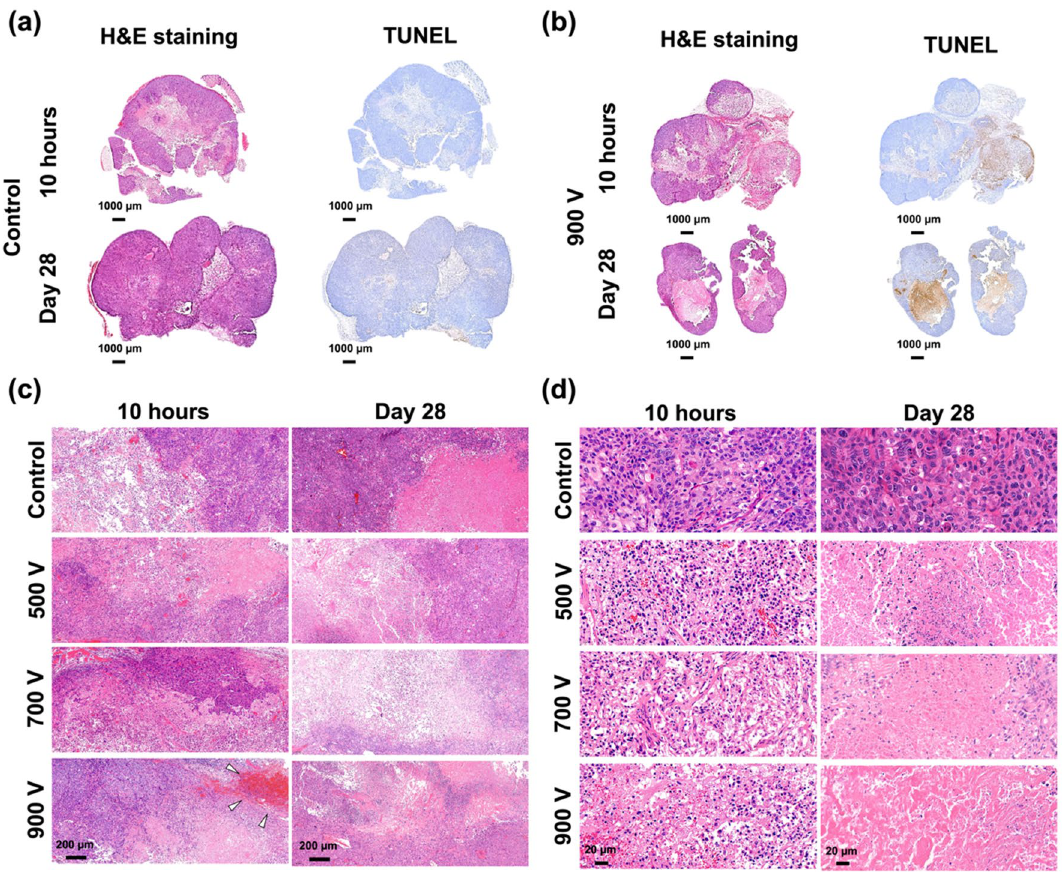
Figure 3. Representative microscopic images of tumor tissue at different applied voltages. ( a – b ) Hematoxylin and eosin (H&E) staining and terminal deoxynucleotidyl transferase-mediated dUTP nick and labeling (TUNEL) assay revealed ( a ) natural necrosis at 10 h and 28 days in the control group and ( b ) destructive findings after irreversible electroporation (IRE) ablation in the 900 V group. ( c ) Histological images showing extensive tumor apoptosis and necrosis in all groups and bleeding (arrowheads) in the 900 V group. ( d ) Magnified histological images showing remnant cells in apoptosis and condensed cellular nuclei at post- procedural 10 h and shrunken nuclei but rich fiber tissues at 28 days. Note: H&E, hematoxylin and eosin; TUNEL, terminal deoxynucleotidyl transferase-mediated dUTP nick and